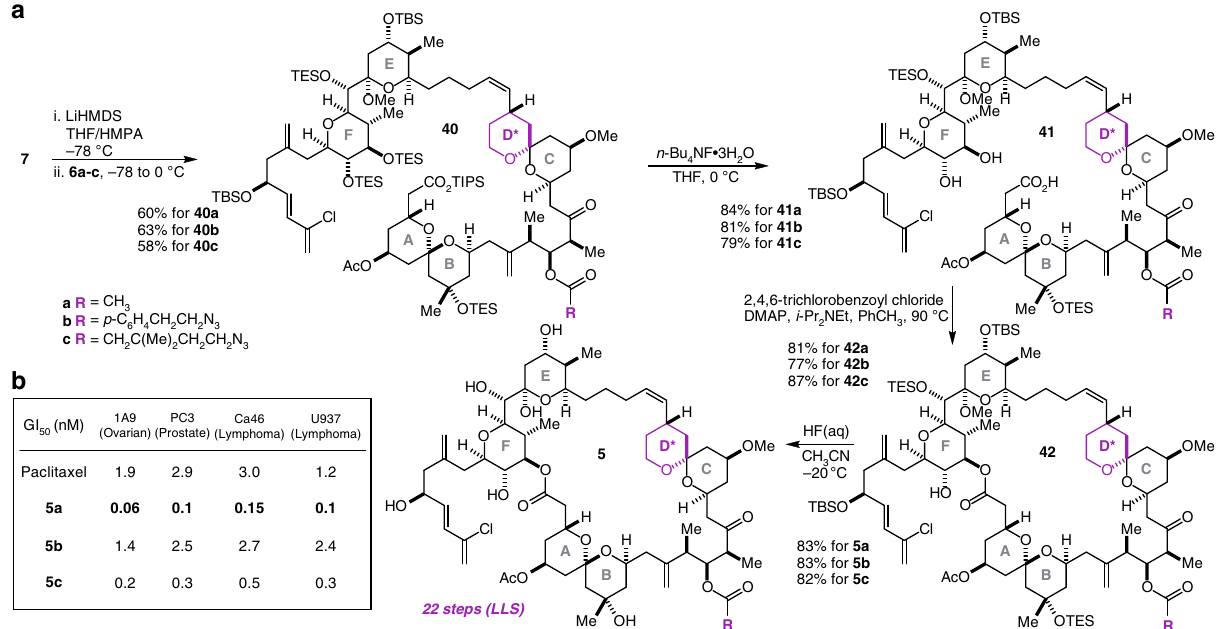
Fig. 5 Completion of the syntheses and cell growth inhibition data. a Four steps couple the ABCD* and EF fragments and produce the spongistatin 1 analogs 5a – c . b Cell growth inhibition assays with four human cancer cell lines establish that the D-ring modi fi ed analog 5a is approximately equipotent with spongistatin 1, while 5c represents a proof-of-concept result that the C(15) acetate may be structurally modi fi ed with only a minimal reduction in potency. LiHMDS lithium hexamethyldisilazide, HMPA